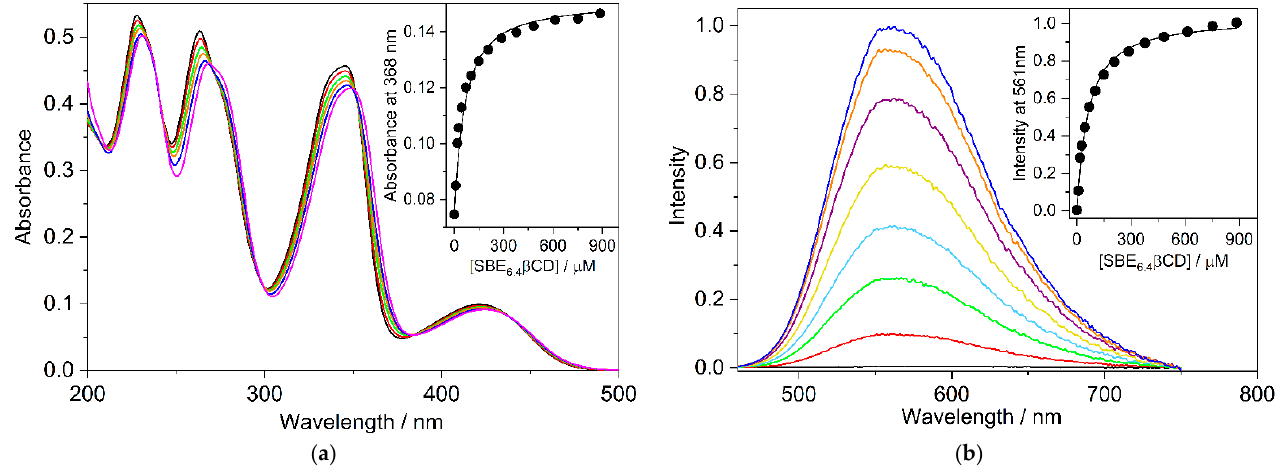
Figure 2. ( a ) Variation of the absorption spectrum of 19.3 μ M B aqueous solution upon addition of 0 (black), 9.4 (red), 18 (green), 44 (orange), 102 (blue), and 886 μ M (magenta) SBE 6.4 β CD at 10 mm optical path. Inset: Absorbance at 368 nm as a function of M SBE 6.4 β CD concentration (•); ( b ) Fluo- rescence spectra of 19.3 μ M B aqueous solution in the presence of 0 (black), 9.4 (red), 18 (green), 44 (pale blue), 102 (ochre), 289 (purple), 886 (orange), and 1800 μ M (blue) SBE 6.4 β CD. Excitation oc- curred at 382 nm. Inset: Fluorescence intensity at 561 nm as a function of SBE 6.4 β CD concentration (•). The experiments were performed at 298 K. The line in the insets stands for the fitted function.